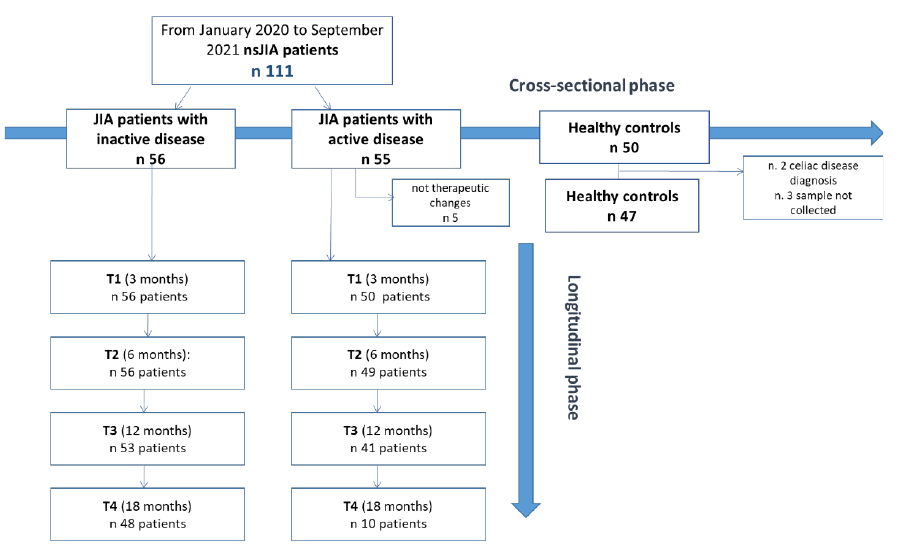
Figure 1. Study design. nsJIA = non-systemic juvenile idiopathic arthritis.